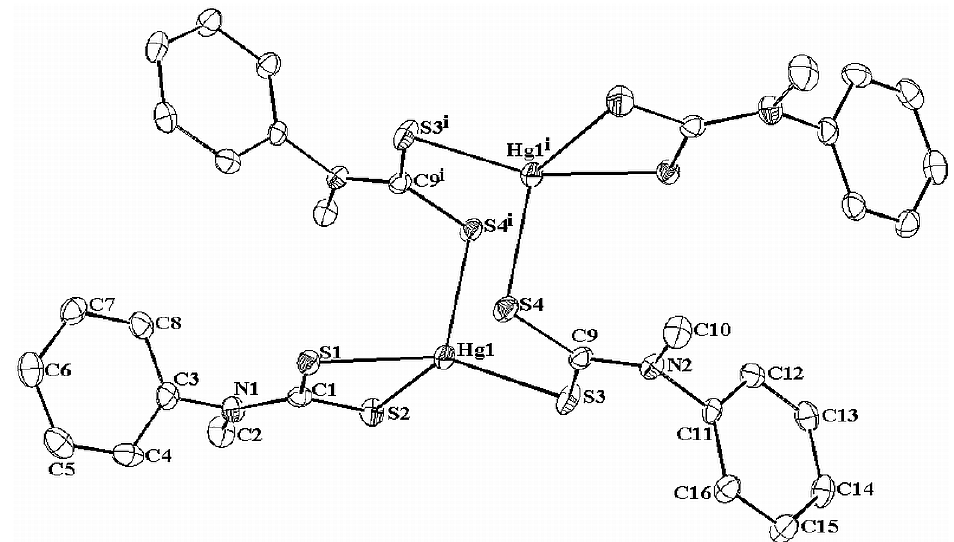
Figure 5. Molecular structure of [(C shown at 50% probability